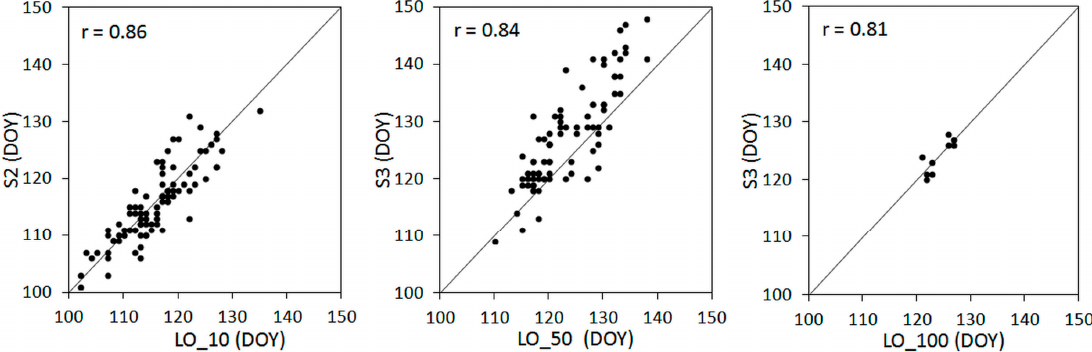
Figure 6. Correlation between the in situ observed spring phenological phases and assigned spring phenological metrics: S2 and beginning of leaf onset LO_10 ( a ), S3 and general leaf onset LO_50 ( b ), S3 and end of leaf onset LO_100 ( c ). The high values of the correlation coefficient indicated very strong correlation between the phenological phases and phenological metrics. DOY, day of